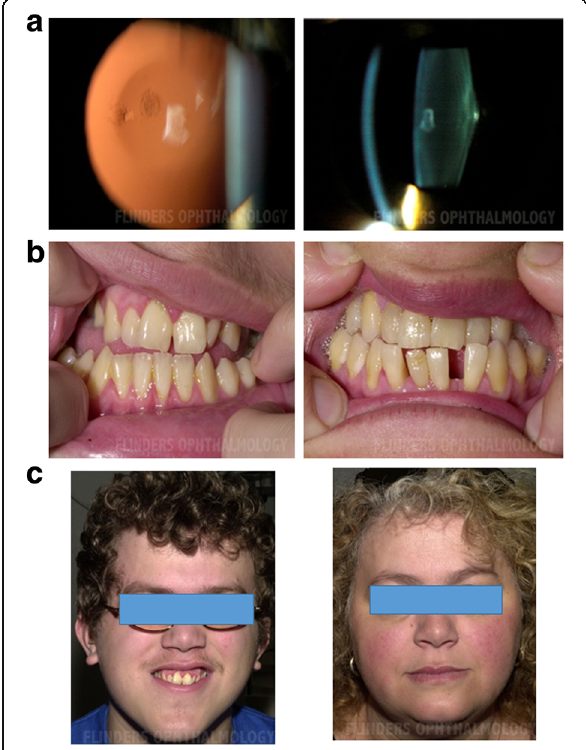
Fig. 2 Clinical features of the syndrome in family CSA108. a Phenotype of syndromic cataract in CSA108.01. Slit-lamp photographs showing posterior polar oil droplet cataract with posterior lenticonus. b Dental abnormalities in CSA108.01 ( left ) and CSA108.02 ( right ). c Facial features in CSA108.01 ( left ) and CSA108.02 ( right ). In particular, note flat mid-face in both, and short philtrum, long/narrow chin and upturned ear lobules in